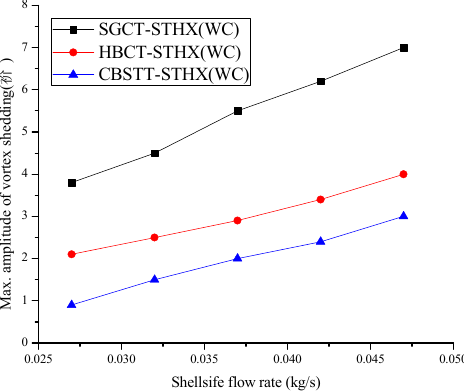
Figure 10. Maximum amplitude of vortex shedding versus mass flow rate.